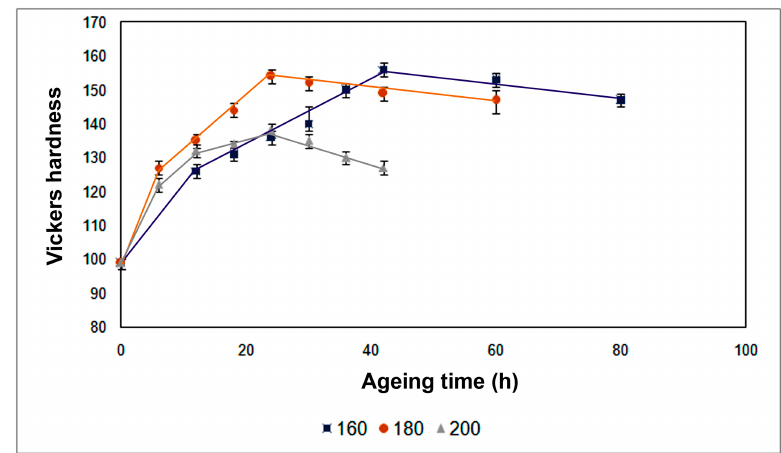
Figure 11. Hardness profiles of the specimens treated at 495 °C for 8 h, with ageing treatments at 160, 180, and 200 °C, respectively. Error bars define the distance between the maximum and minimum values vs. the average value.